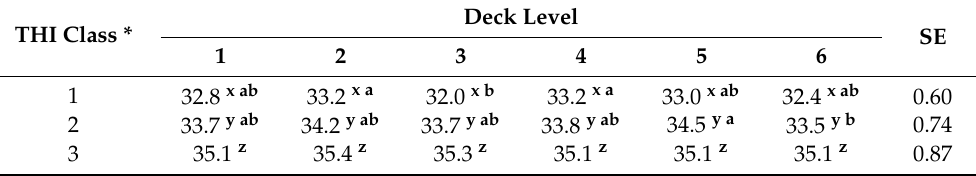
Table 4. Effect of the interaction between the class of the Temperature Humidity Index (THI) and deck level on the maximum surface temperature ( ◦ C) recorded at unloading by a thermal camera on the ocular region of Italian heavy pigs transported approximately for 30 min under commercial conditions (least square means).